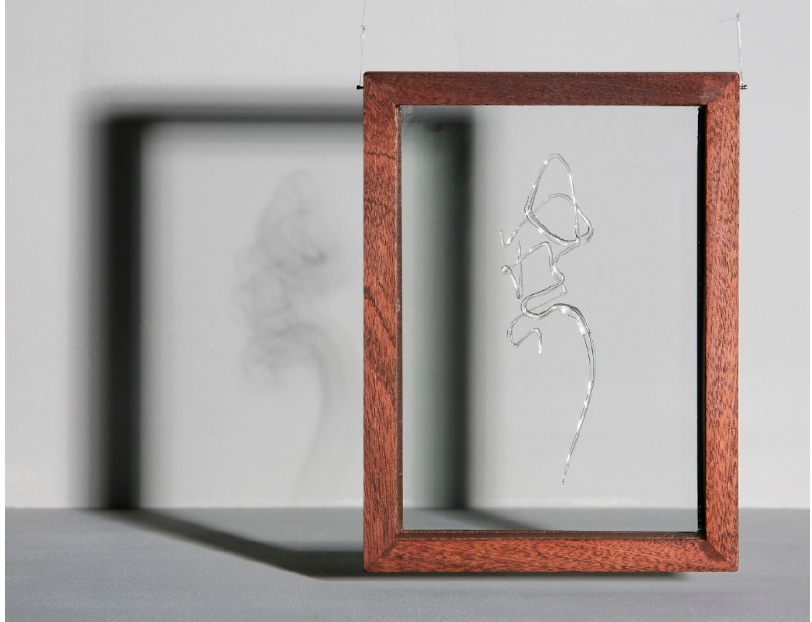
Figure 2. Ghost (2010) by Ayako Tani. Lampworked borosilicate glass and wood frame. Variable size.